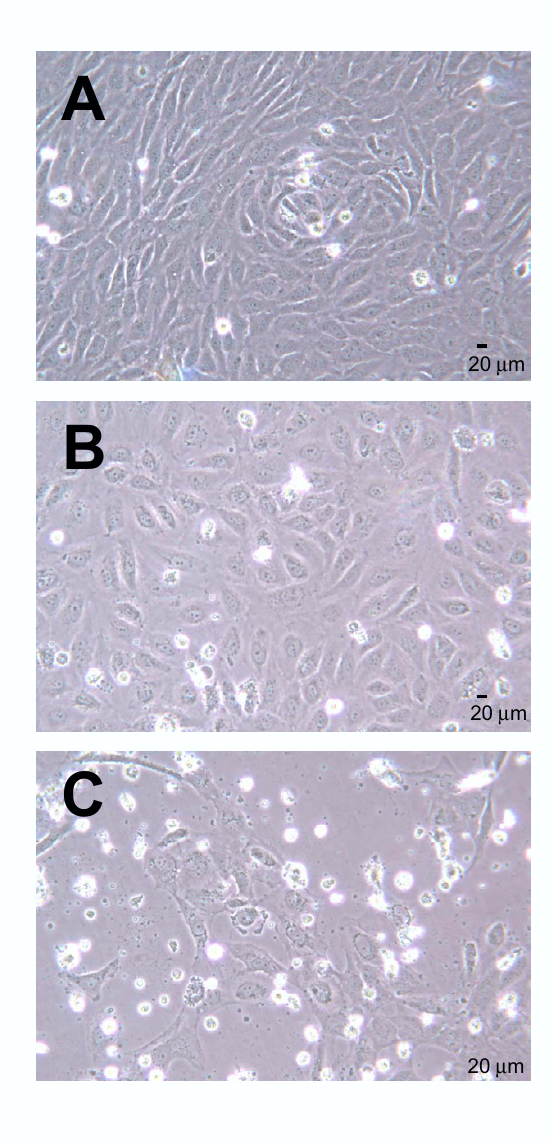
Figure 2 Phase contrast photomicrographs of HUVEC culture after treatment with camptothecin Confluent HUVEC at 48 hrs in culture were treated for 24 hrs with (A) 0.5 % DMSO: confluent culture, (B) 500 nM CPT: confluent culture with about 20–30% lower cell density as compared with A ; (C) 5 µ M CPT : apoptotic culture with about 60–70 % desq- uamation, bright objects represent floating cell fragments including apoptotic bodies. Phase contrast photomicrographs (200 × ) are shown.